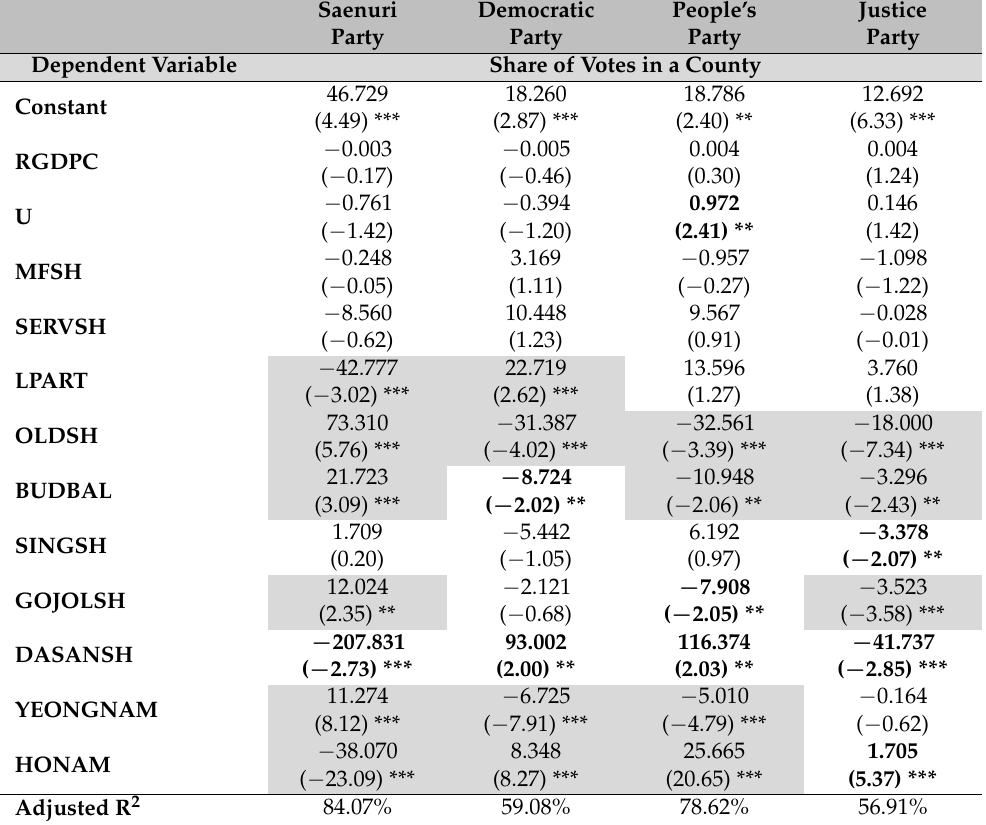
Table 5. The OLS Modeling of Koreans’ Voting Choice, the General Elections of 2016.